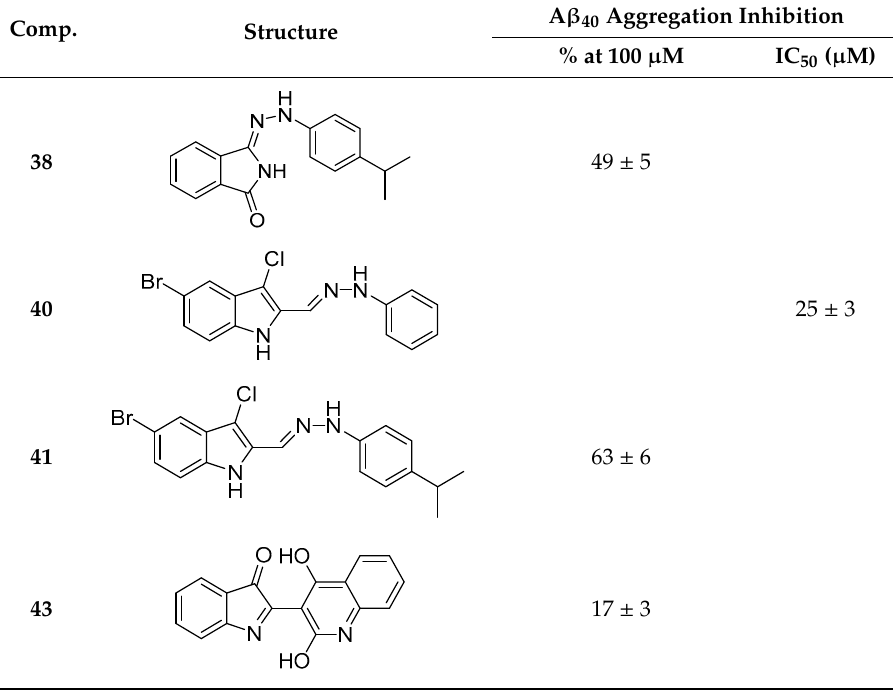
Table 4. Inhibition data of new derivatives 38 , 40 , 41 and 43 . Comp.